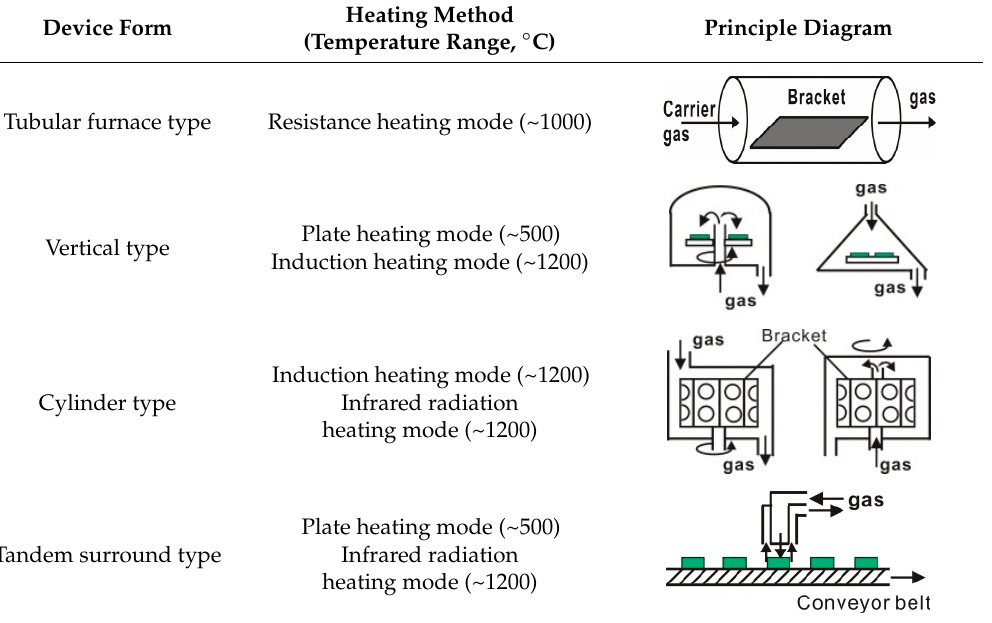
Table 1. Different CVD devices, heating mode and basic schematic diagram 1 .